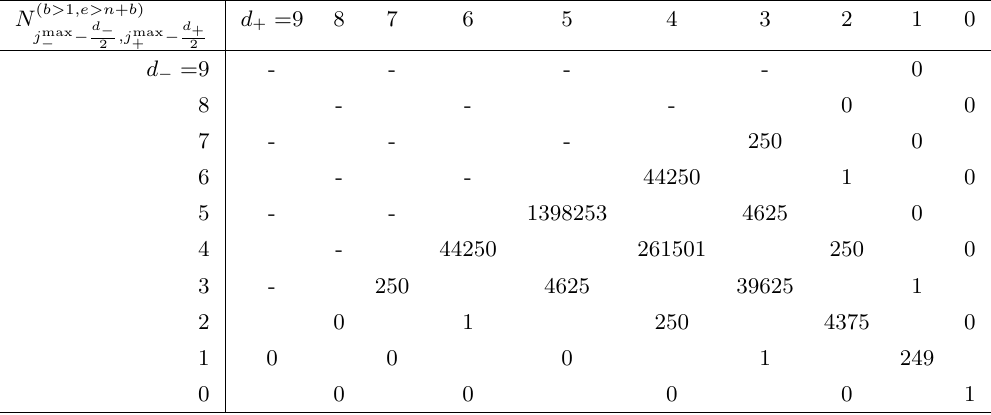
Table 5 . Asymptotics of refined BPS invariants of the massless E-string for d = 2 n +1 with n = 4. We indicate only those vanishings by 0 that are not already implied by the checkerboard